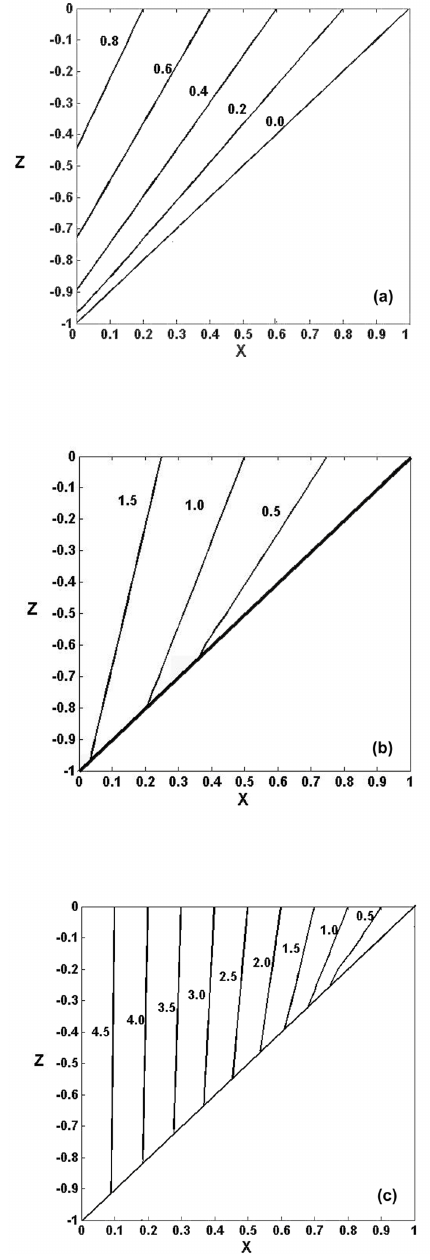
Fig. 5. Contour plots of T 1 /2 on a section of H perpendicular to the Y axis: (a) V 2 = 1, (b) V 2 = 0 . 5, (c) V 2 = 0 . 2 ( α =